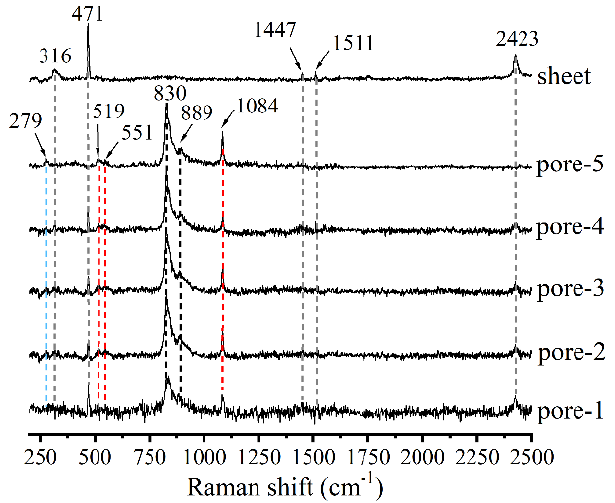
Figure 4. Raman spectra of hydration products in different pores (treated by 65% RH condition). Figure 5 is the Raman spectra of the control. Except for the peaks of unhydrated C 3 S (829 and 890 cm − 1 ), the broad shoulder signal near 513 and 558 cm − 1 were speculated to belong to the antisymmetric bending vibration of O-Si-O in unhydrated C 3 S [37,38]. The peak at 668 cm − 1 was characteristic of Si-O-Si symmetrical bending vibration in Q 2 silicate chains of C-S-H. The broad and strong peak at 1114 cm − 1 was assigned to the hydroxylated species (Si-OH), which was due to the decrease in the proton numbers which bridged on Si-O of Q 2 silicate tetrahedra [32,38]. The shift at 355 cm − 1 was the characteristic band of Ca(OH) 2 [37,38]. The signals around 1504 and 2234 cm − 1 also belonged to Ca(OH) 2 [39].